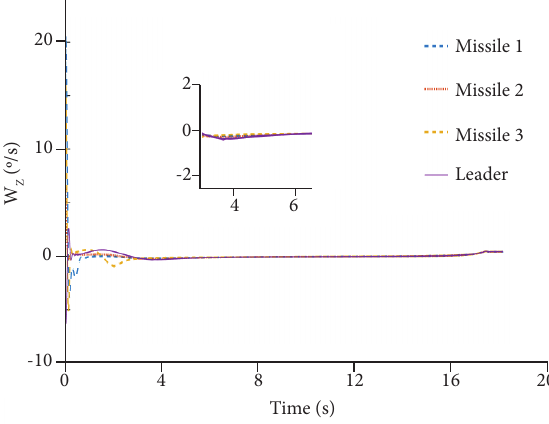
Figure 7. Pitch angular velocities of the interceptors obtained using the improved cooperative control strategy.